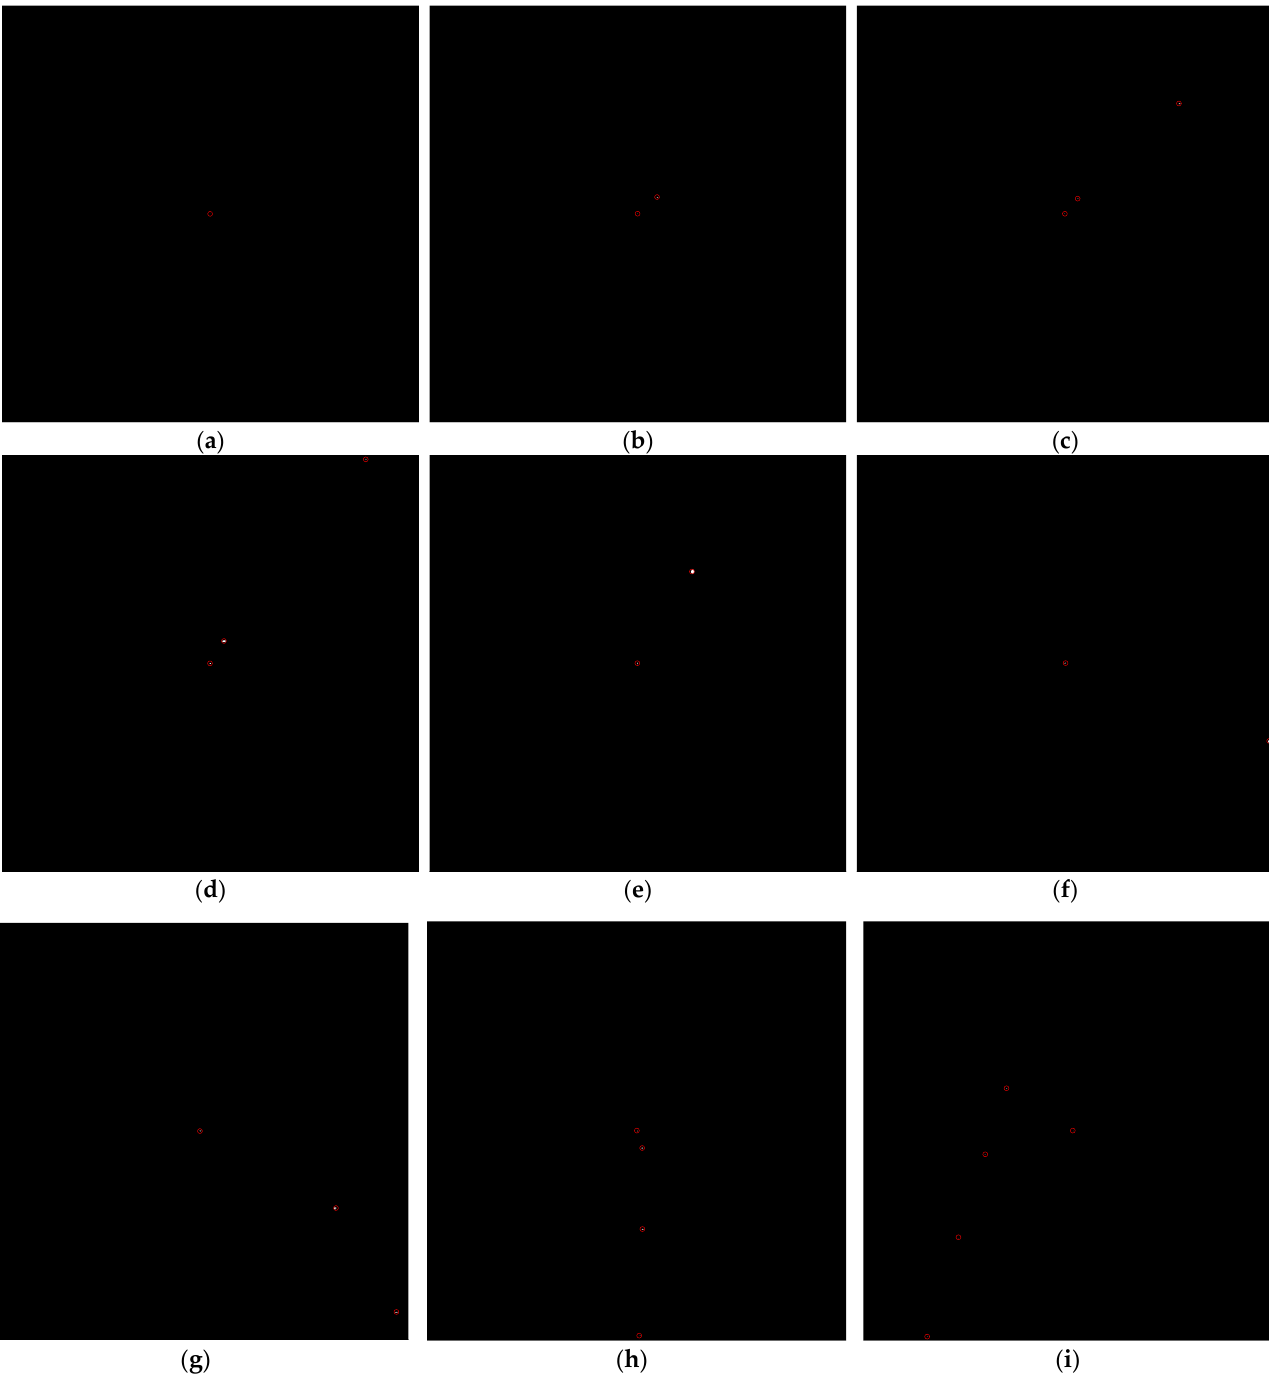
Figure 11. The birth of each target ( a ) First target appears, ( b ) Second target appears, ( c ) Third target appears, ( d ) Fourth target appears, ( e ) Fifth target appears, ( f ) Sixth target appears, ( g ) Seventh target appears, ( h ) Eighth target appears, ( i ) Ninth target appears.